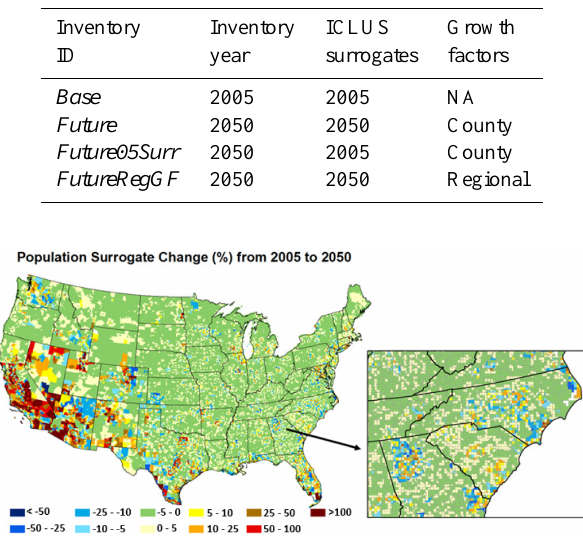
Figure 7. Population-based surrogate change (%) for CMAQ 12 km modeling